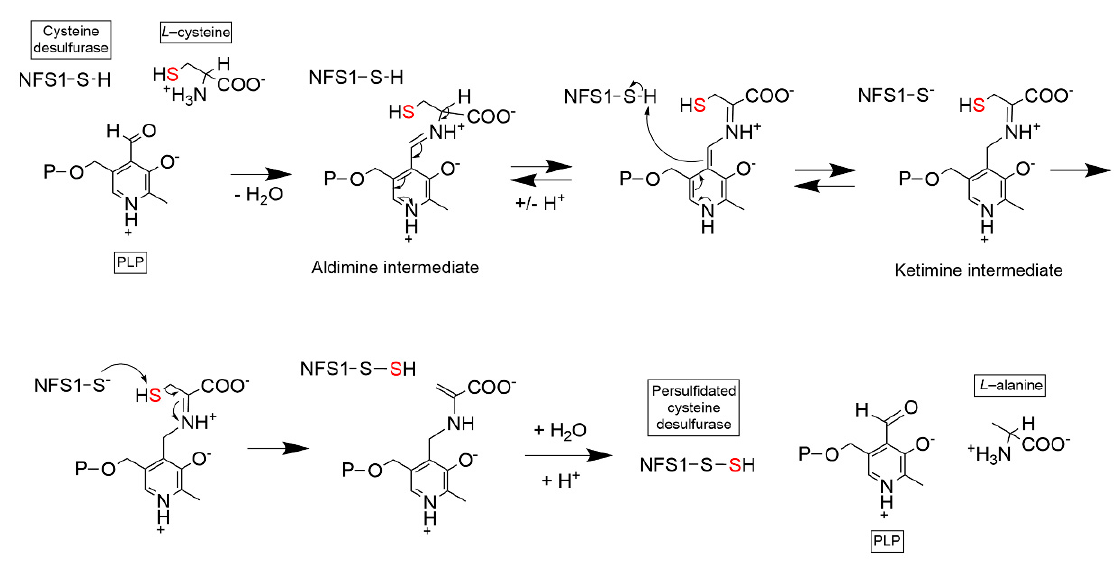
Figure 3. Enzymatic mechanism of PLP–dependent NFS1 cysteine desulfuration. PLP cofactor is attached to NFS1 via Schiff base at NFS1 Lys258. PLP reacts with free L -cysteine to generate an intermediate aldimine adduct and a ketimine adduct. The catalytic Cys381 residue becomes persulfidated using PLP–cysteine as a substrate. Hydrolysis releases L –alanine from PLP. NFS1: NFS1 protein highlighting Cys381 residue; P: Phosphate group.